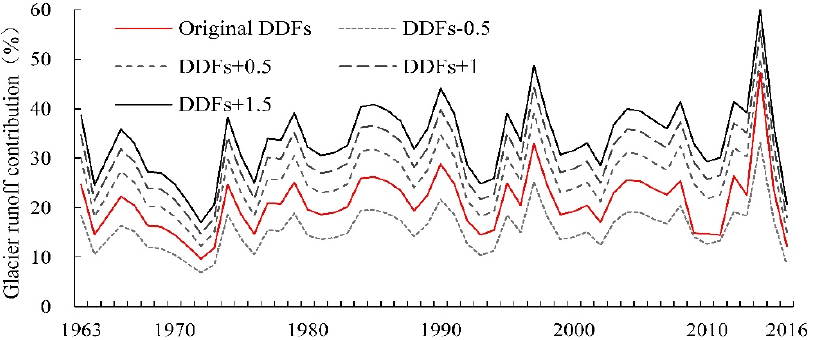
Figure 11. Sensitivity analysis of the glacier-enhanced soil and water assessment tool model to the degree-day factors.